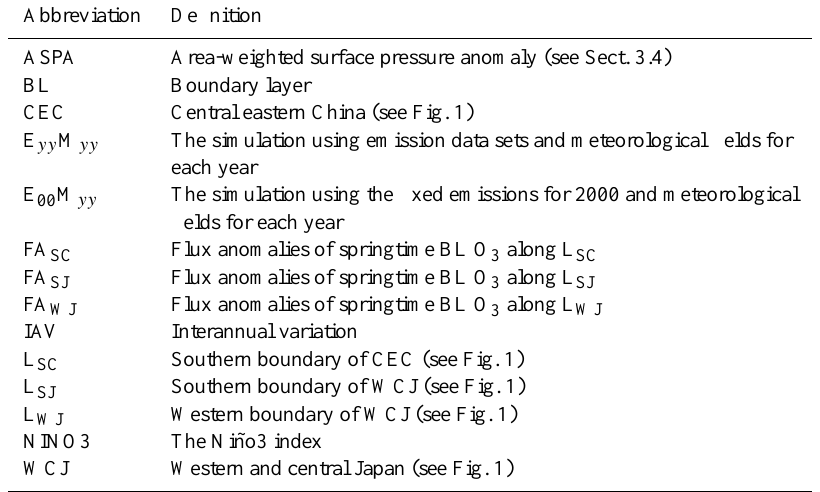
Table 1. Abbreviations used in the